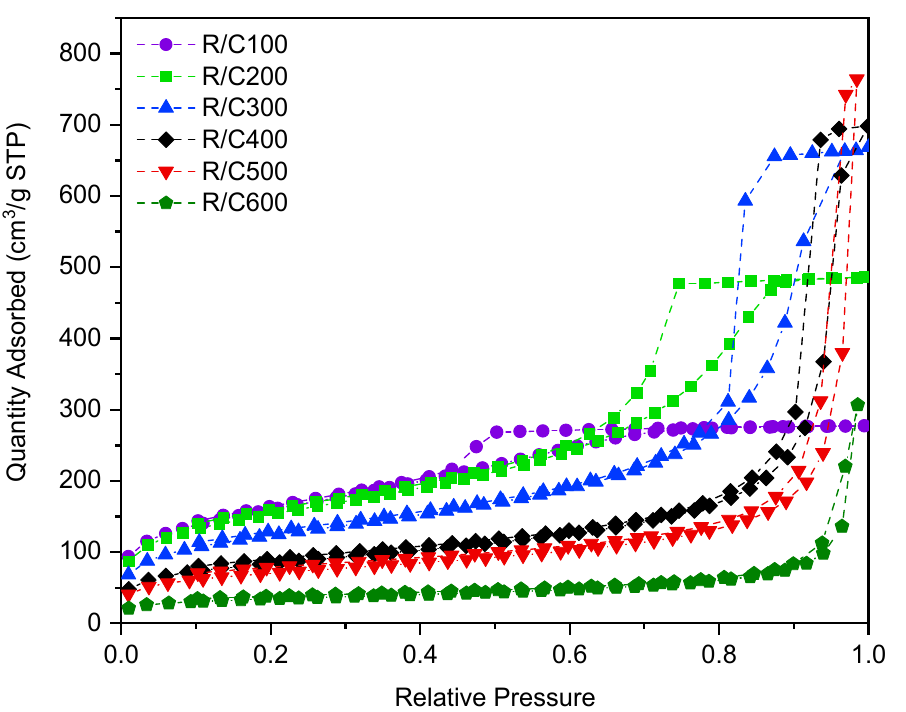
Figure 2. Nitrogen adsorption isotherms for sodium carbonate gels at resorcinol/catalyst molar ratios (R/C ratios) 100–600. STP abbreviates standard temperature and pressure.